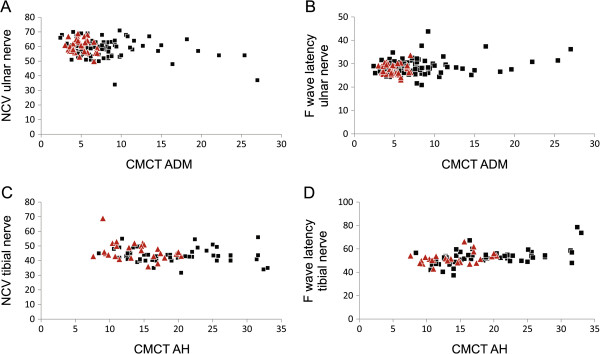
Correlation of central and peripheral motor damage. (A and B) Nerve conduction velocity (NCV) and F wave latency of the ulnar nerve correlated with central motor conduction time (CMCT) to the abductor digiti minimi muscle (ADM) (r = 0.249; p < 0.004 and r = −0.280; p < 0.002, respectively). (C and D) Accordingly, NCV and F wave latency of tibial the nerve correlated with CMCT to abductor hallucis muscle (AH) (r = 0.463; p < 0.0001 and r = −0.270; p < 0.09, respectively). Patients with SPG4 mutations are indicated by red triangles, other patients by black squares.